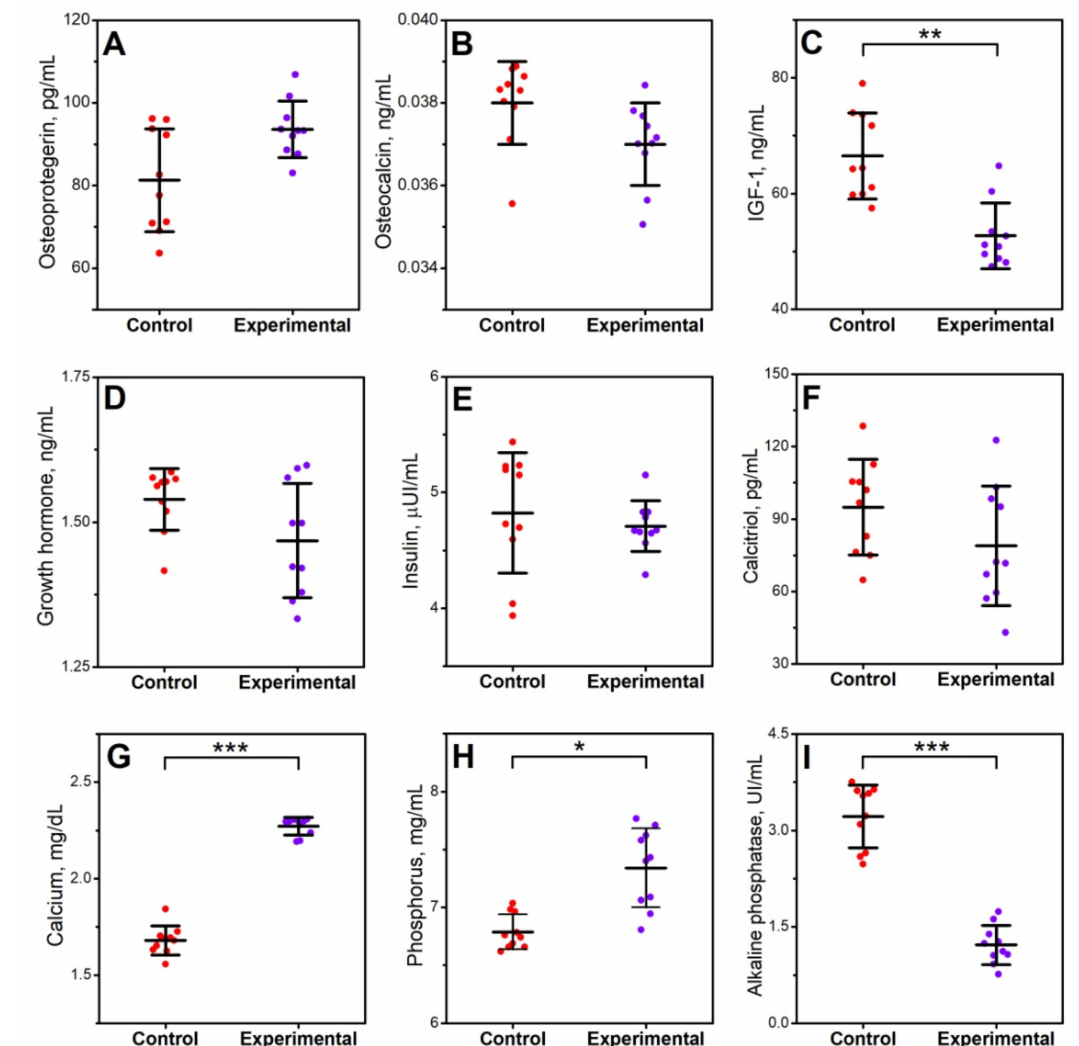
Figure 1. The effect of C. perfringens infection on hormonal and biochemical analysis in blood serum of animals at the age of 42 days: ( A ) osteprotegerin; ( B ) osteocalcin; ( C ) insulin-like growth factor 1 (IFG-1); ( D ) growth hormone; ( E ) insulin; ( F ) calcitriol; ( G ) calcium; ( H ) phosphorus; and ( I ) alkaline phosphatase. Control—the control group of birds; experimental—the experimental group of birds subjected to Clostridium perfringens infection. Data are mean values ± SD (whiskers) from n = 10 birds. Statistical significance: * p < 0.05; ** p < 0.01; *** p < 0.001 (two-tailed Student’s t -test, t -test with Welch’s correction, or Mann–Whitney U